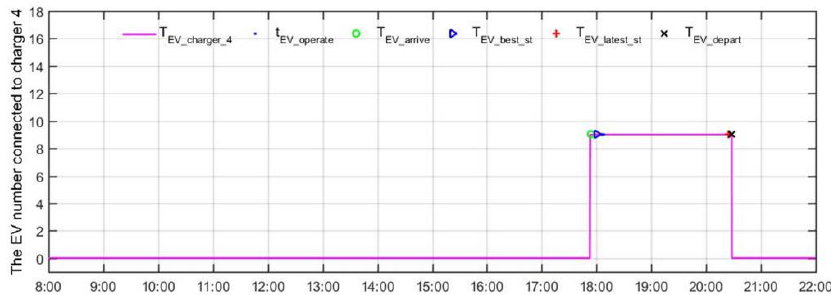
Figure 31. Operating time of EVs connected to charger 4 under SPVA.